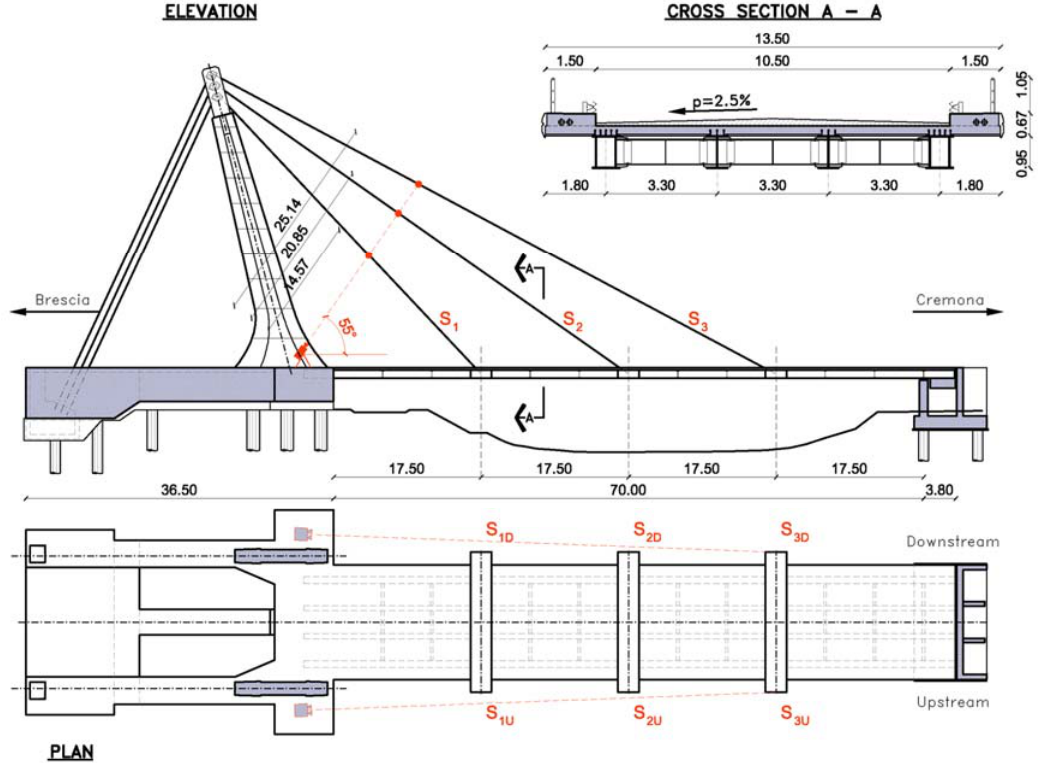
Figure 6. Elevation, plan and typical cross-sections of the cable-stayed bridge over the river Oglio (dimensions in m). Positions of the microwave sensor in the survey of the two arrays of